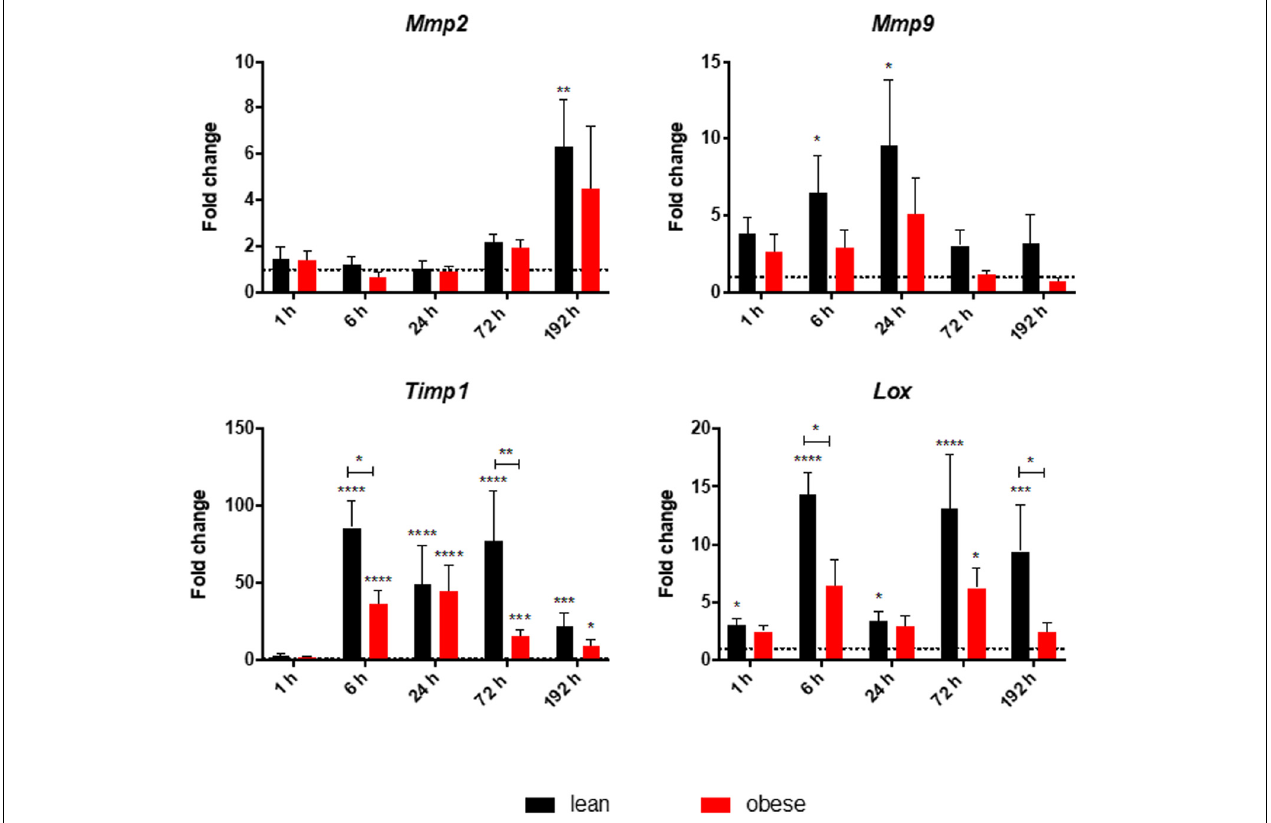
FIGURE 7 | Decreased early and late response of gene level of ECM organizing genes in obese mice. Gene expression profile of ECM organizing genes Mmp2 , Mmp9 , Timp1, and Lox were determined in injured muscle of lean and obese control and trauma animals. Statistical significance was determined using two-way ANOVA followed by an uncorrected Fisher’s LSD test ( α = 0.05). * p < 0.05, ** p < 0.01, *** p < 0.001, **** p < 0.0001. Indicators of significance directly above the bars of the diagram indicate a statistical difference to the control, while starts above the connector line show differences between the two diets at that specific time